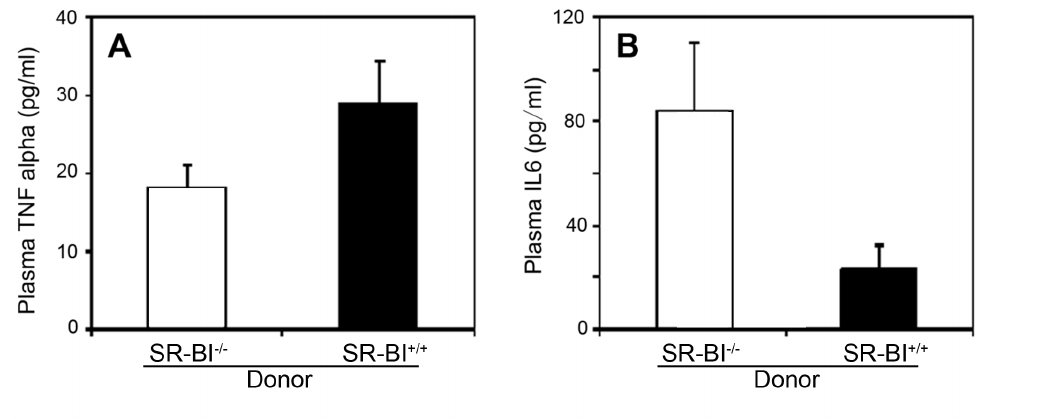
Figure 4. Effects of restoring SR-BI expression in BM derived cells on plasma levels of TNF a and IL-6 in HFCC diet fed SR-BI-null/ apoE-hypomorphic mice. A. TNF a and B. IL-6 levels in plasma from control SR-BI 2 / 2 R SR-BI 2 / 2 (white bars) and SR-BI + / + R SR-BI 2 / 2 mice (black bars) after 3 weeks of HFCC diet feeding. Shown are mean levels for n=8 mice per group. Error bars correspond to standard errors. A. TNF a levels were not statistically significantly different. B. IL-6 levels were statistically significantly different. P=0.028. Statistical analysis was by the Mann-